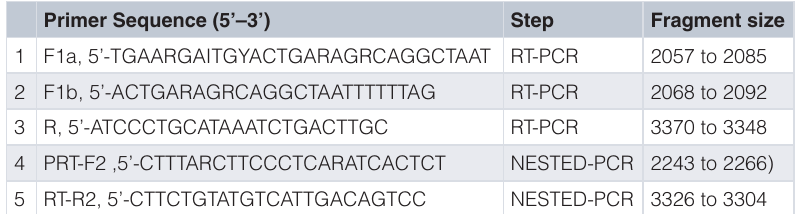
Table 1. Primers used in the RT-PCR and nested PCR